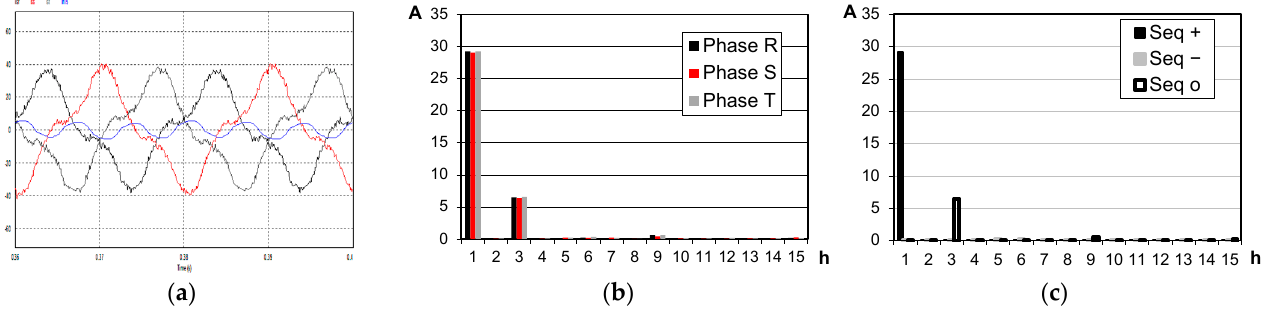
Figure 13. Case C - ( a ) supply currents (phases R , S , T , and neutral). ( b ) Harmonic spectrum of phase components. ( c ) Harmonic spectrum of the symmetric components.